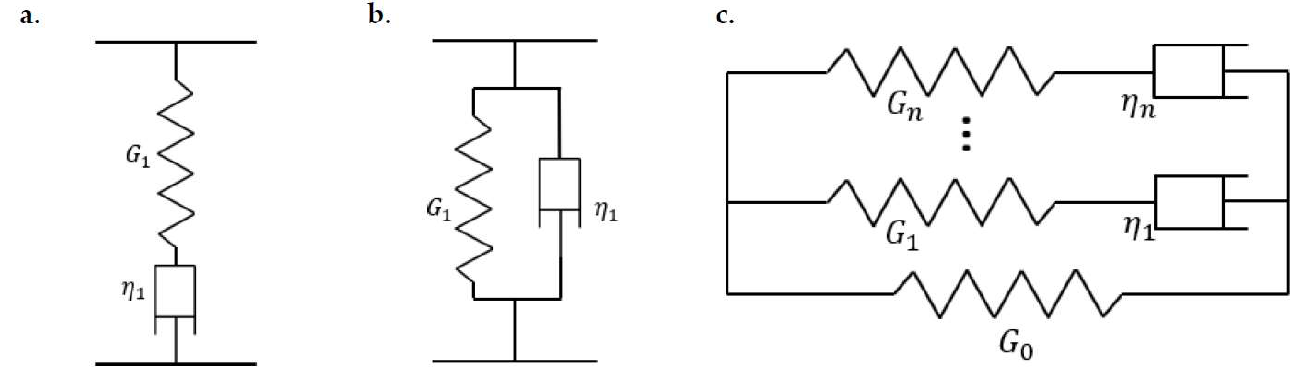
Figure 1. Rheological models describing the behaviour of linear viscoelastic materials: ( a ) Maxwell model, ( b ) Kelvin–Voigt model, and ( c ) generalized Weichert model: G is the spring stiffness and η is the dashpot viscosity.